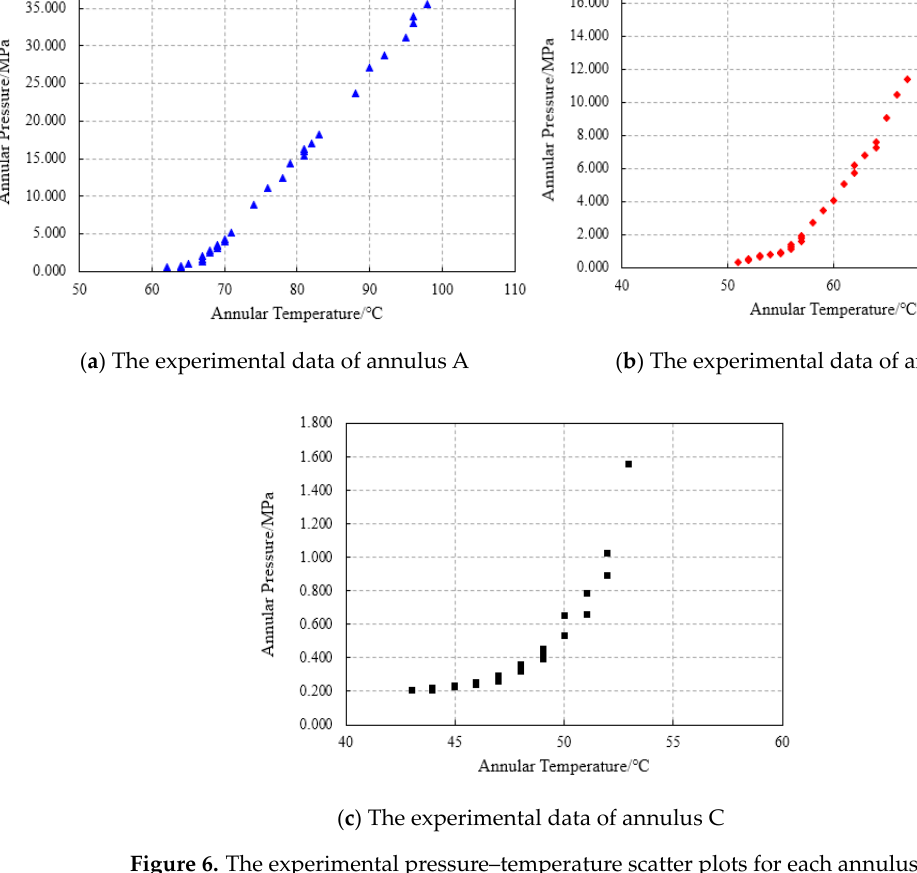
Figure 6. The experimental pressure–temperature scatter plots for each annulus.